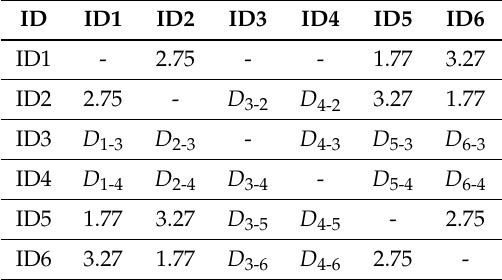
Table 1. Distance matrix used in the MarvelMind software to determine the position of the mobile beacon (Bm).